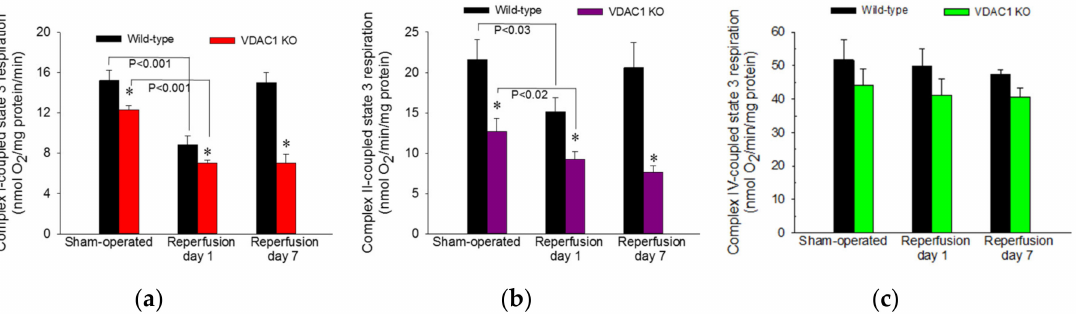
Figure6. DeletionofVDAC1decreasesmaximummitochondrialrespirationinnon-injuredrenalcortical tissue and hinders recovery of respiration after ischemia. State 3 respiration coupled to the oxidation of electron donors to complex I (5 mM glutamate + 5 mM malate) ( a ), complex II (10 mM succinate + 0.1 µ M rotenone) ( b ), and complex IV (2 mM ascorbic acid + 1 mM